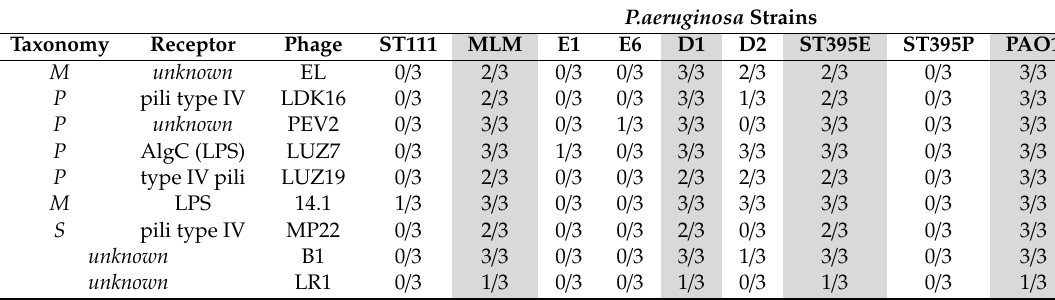
Table 4. Host range of individual